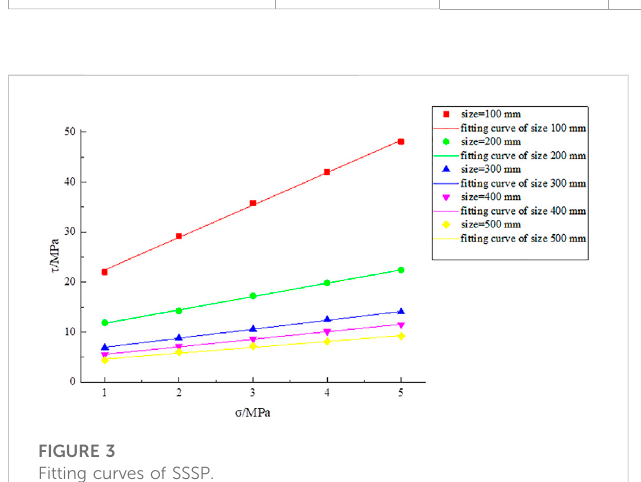
FIGURE 3 Fitting curves of SSSP.